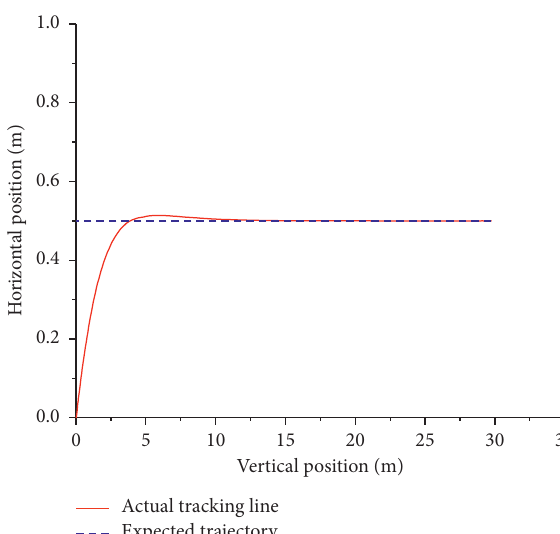
Figure 8: Position change during linear trajectory tracking.